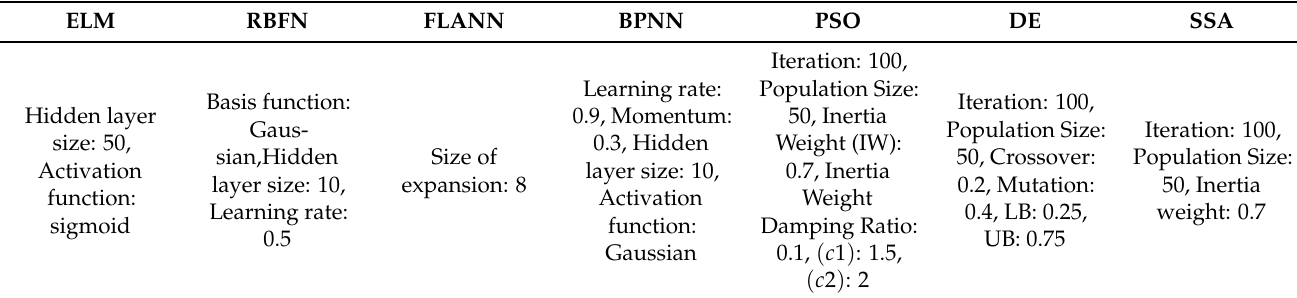
Table 4. Various parameter values used during model development.